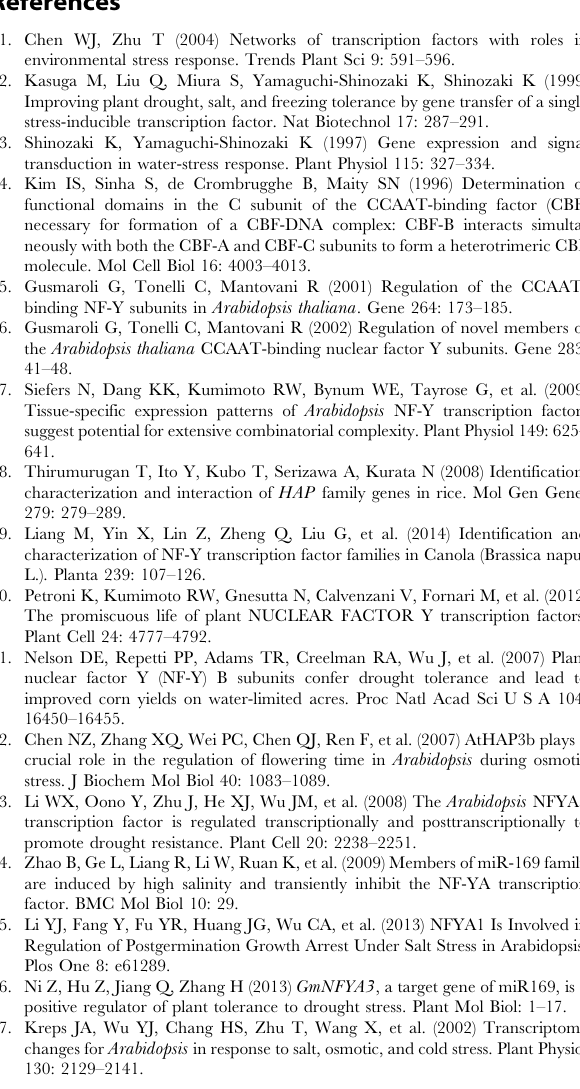
Figure S4 Semi-quantitative RT-PCR analysis of BnNF- Y expression in control leaves and roots. RT-PCR analysis was performed on untreated leaf (L) and root (R) tissue samples. The 18S housekeeping gene and BnNF-Ys were amplified for 28 cycles and 35 cycles, respectively. Figure S5 Diagrammatic representation of NF-Y pro- moter regions. Arabidopsis NF-YA (A), NF-YB (B), and NF-YC (C) promoter regions. Symbols above the top line indicate elements in the forward orientation, and those below the bottom line are in the reverse orientation. MYC(CANNTG) sequences are between the double lines, to indicate their palindromic nature. Numbers are the distance in nucleotides between the sequences and ATG start codon. Table S1 Primers for BnNF-Y promoters . F indicates the PCR forward primer and R indicates the PCR reverse primer.